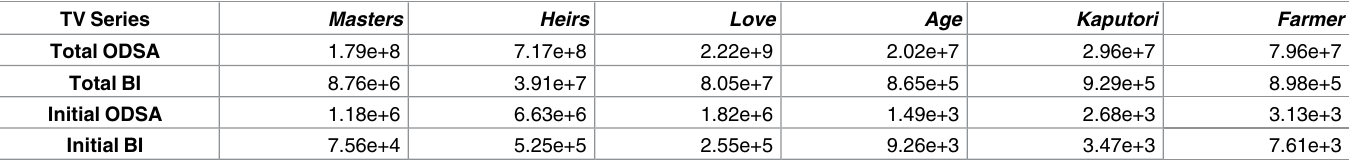
Table 4. Comparison of other basic parameters of the six